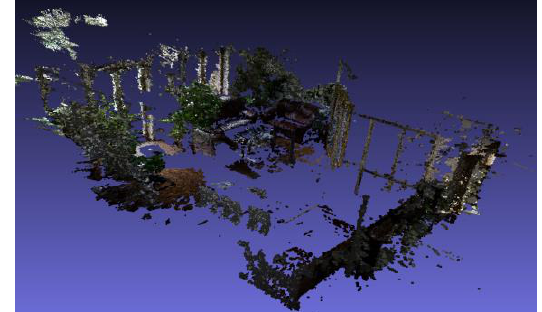
Figure 3. Point cloud created by C3DC QuickMac in MicMac.